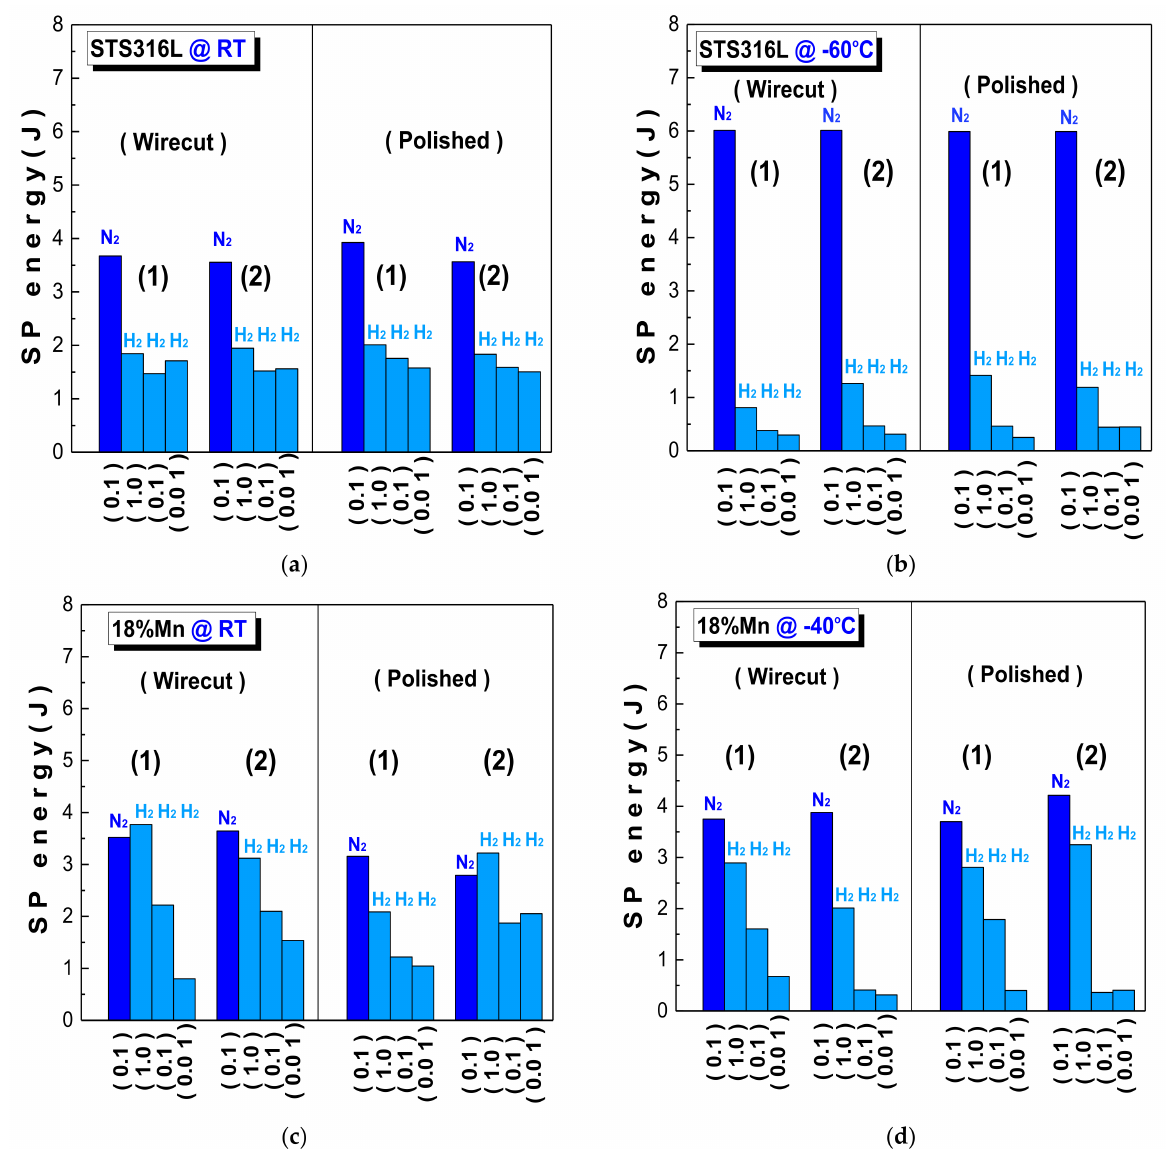
Figure 5. Comparisons of SP energies absorbed by specimens tested at RT and lower test temperatures at each punch velocity, separated by surface finish for STS316L steel ( a , b ) and 18 wt% Mn steel ( c , d